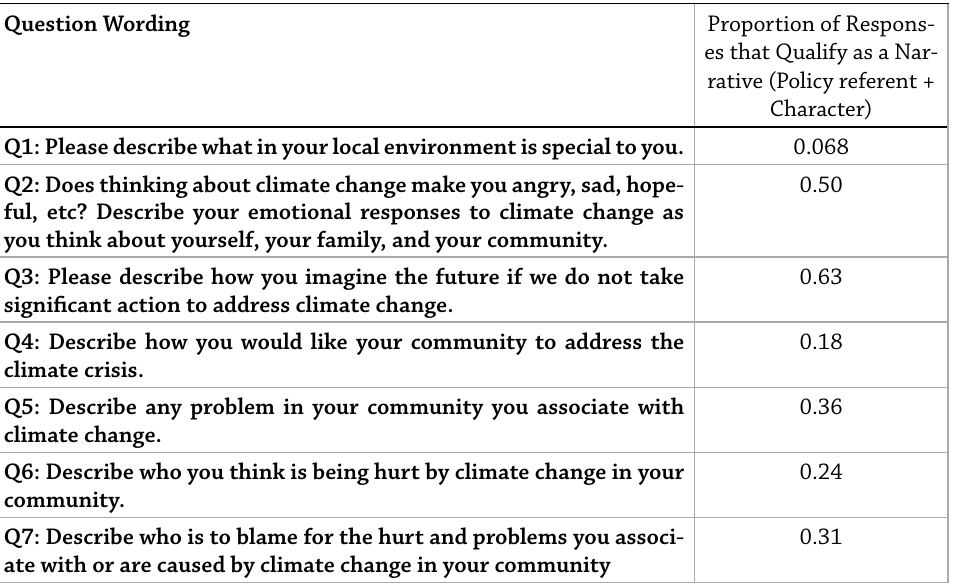
Table 1: Question Wordings and Rates of Narrative Responses Question